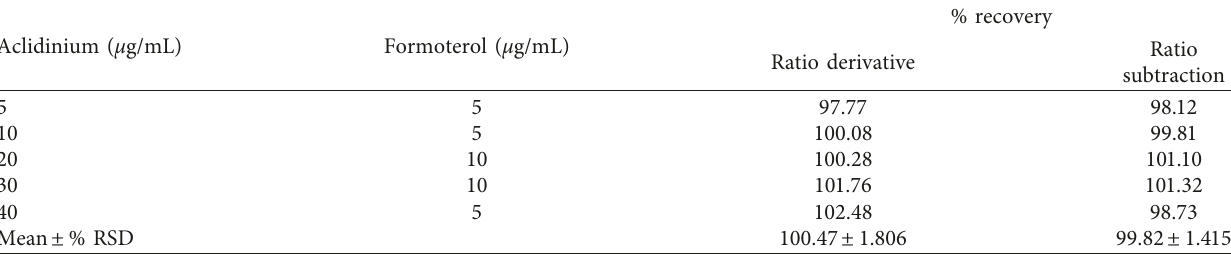
Table 2: Determination of aclidinium in mixtures with formoterol by the proposed ratio derivative and ratio subtraction